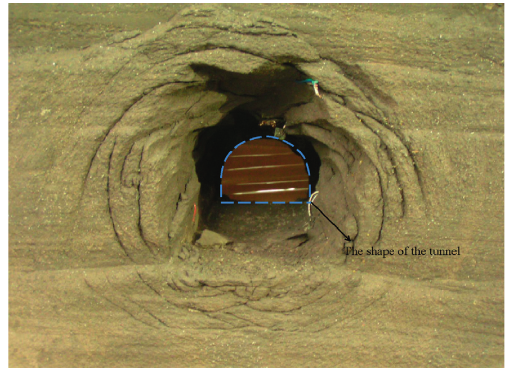
Figure 3: Zone disintegration of the model